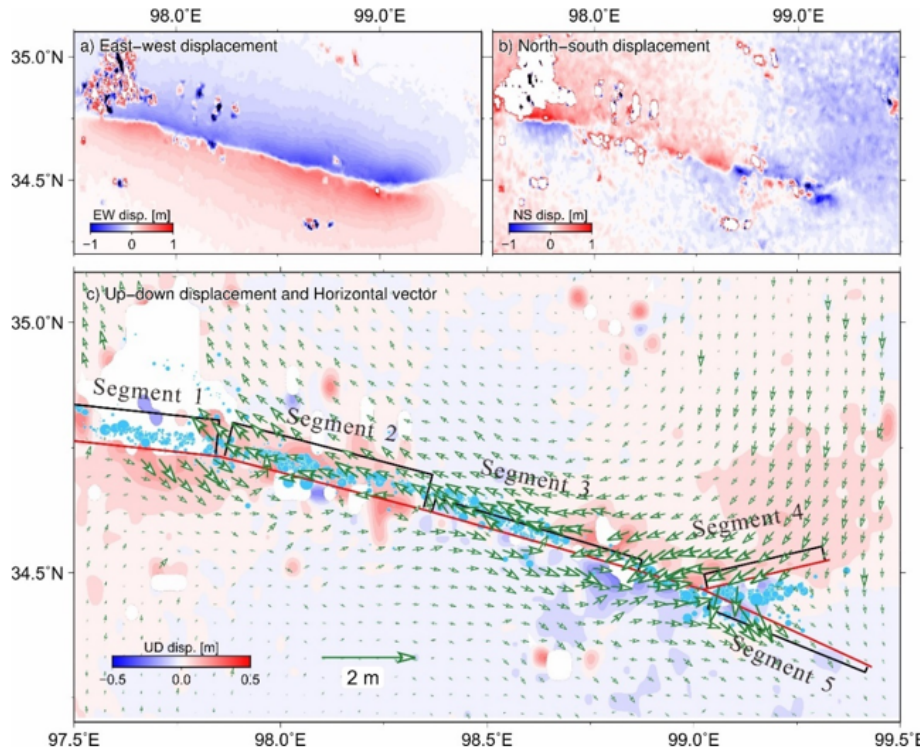
Figure 3. Three-dimensional displacement fields of the Maduo earthquake. ( a ) East-west displace- ment component (positive to the east). ( b ) North-south displacement component (positive to the north). ( c ) Vertical displacement component (the upward direction being positive) and horizontal deformation vector field. Arrows indicate horizontal displacement. Red lines indicate the ground trace of the fault plane from our fault model. Black lines indicate the surface projection of the fault plane from our fault model.